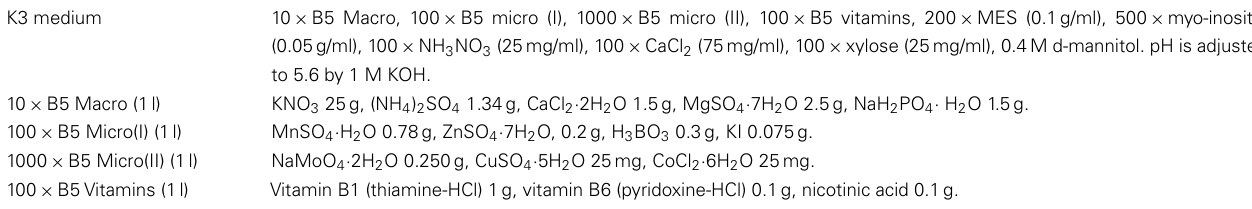
TableA1 | K3 medium used for rice protoplast system.